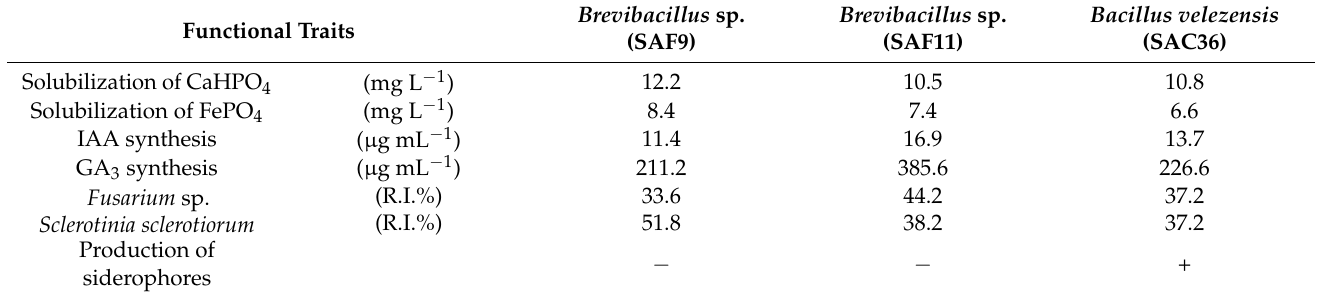
Table 1. Multifunctional characterization of SAF9, SAF11, and SAC36 rhizobacteria collected from Glycine max L. seedlings grown in soil sampled from an agricultural field with a 30-year history of soybean